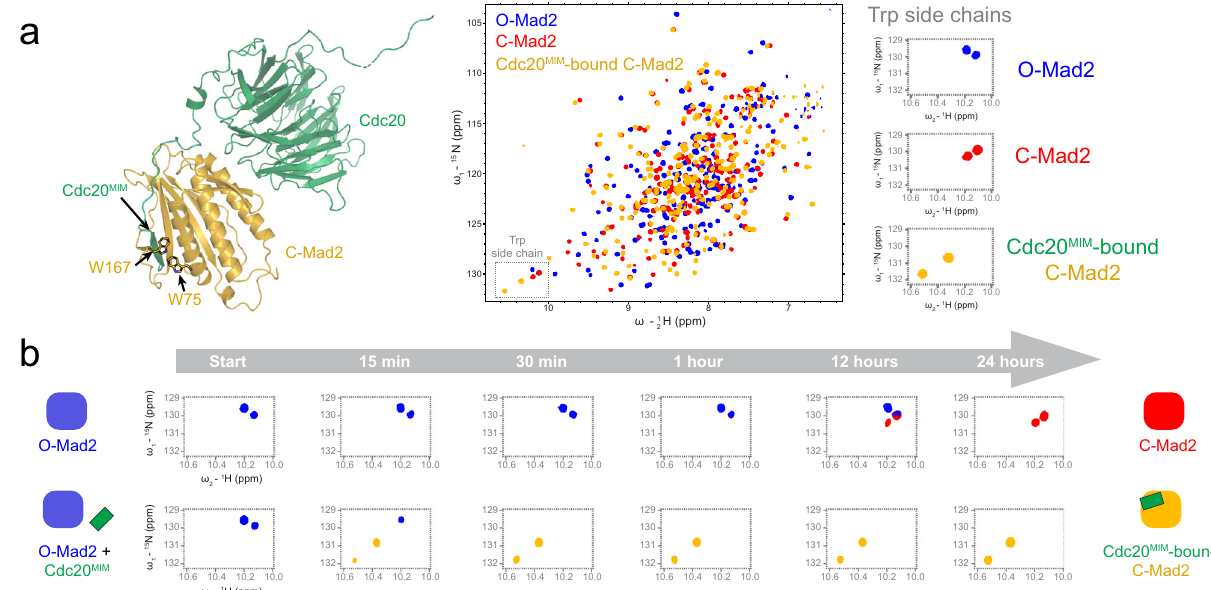
Fig. 7 | NMR-monitor conversion of O-Mad2 to C-Mad2 shows that Cdc20 MIM greatly enhances the rate of Mad2 conversion. a C-Mad2 (orange) bound to Cdc20 (green) from PDB 6TLJ 90 , with Mad2 Trp167 and Trp75 side chains depicted as sticks. The middle panel shows a 1 H, 15 N 2D HSQC of 15 N-labelled O-Mad2 (blue), C-Mad2(red),and Cdc20 MIM -bound C-Mad2 (orange). All Mad2 samples contain an R133A mutation to prevent Mad2 dimerisation 23 . The C-Mad2 sample additionally contains an L13A mutation which favours the C-Mad2 state 57 . Cdc20 MIM -bound C-Mad2samplewaspreparedbyaddinga1:2excessofCdc20 MIM peptidetoO-Mad2 with an R133A mutation. The indole N-H resonances for Mad2 tryptophan side chainswereusedasreportersforMad2conformationandareboxedinthespectra. The right panel shows the close-up views of the two tryptophan indole N-H